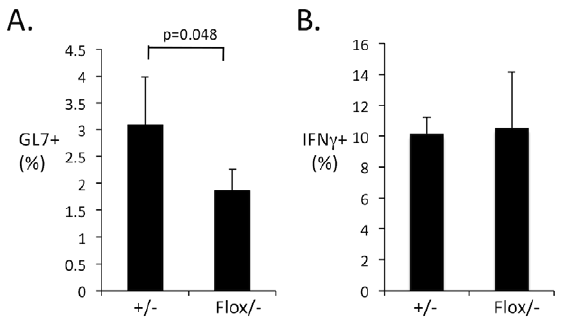
Figure 10. B cell-intrinsic Myd88 regulates germinal center B cells but not CD4 T cell IFN c expression. Heterozygous mice (CD19-Cre/Myd88 + / 2 ) or mice with B cell specific deletion of Myd88 (CD19-Cre/Myd88 flox/ 2 ) were infected with FV, At 14 dpi, splenocytes suspensions were analyzed by flow cytometry for GL7 expression in CD19 + B cells ( A ) and for IFN c expression in CD4 + , TCR b + T cells ( B ). Each bar represents the average of four